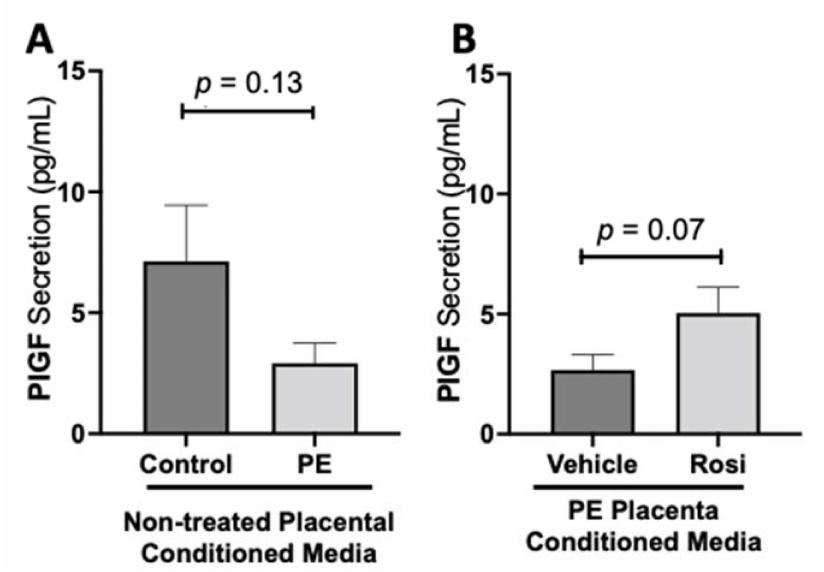
Figure 3. There are no significant differences in Endothelin-1 secretion from healthy or preeclamptic placentas with or without drug treatment. Secretion of Endothelin-1 was measured via Luminex assay from conditioned media from non-treated control and preeclamptic (PE) placentas ( A ) and vehicle- or Rosiglitazone (Rosi)-treated PE placentas ( B ). There was no significant change in ET-1 secretion between PE and control placentas ( A , n > 10) and between vehicle and Rosi-treated PE placentas in the PE compared to control placentas however this was not statistically significant ( B , n = 14). (Protein secretion was measured by a Luminex assay where experimental values were determined relative to a standard curve. Statistical analysis was performed by student’s t -test to determine significant differences between groups, bar plots and data reported are reported as mean pg/mL values ± SEM).